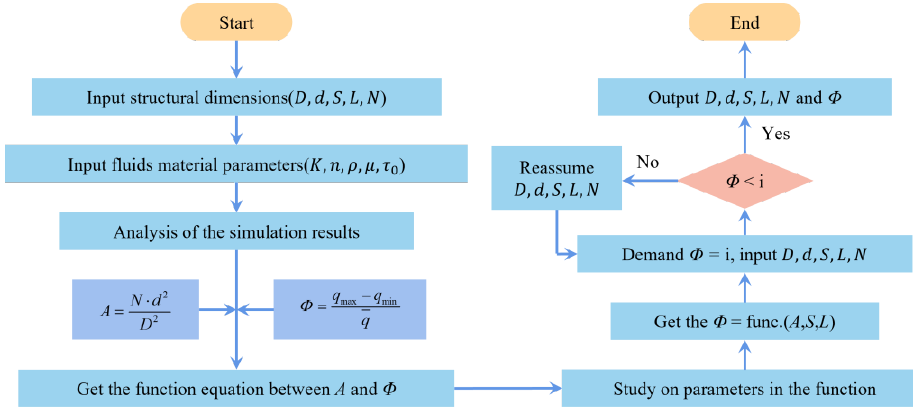
Figure 11. Flow chart of the prediction model.